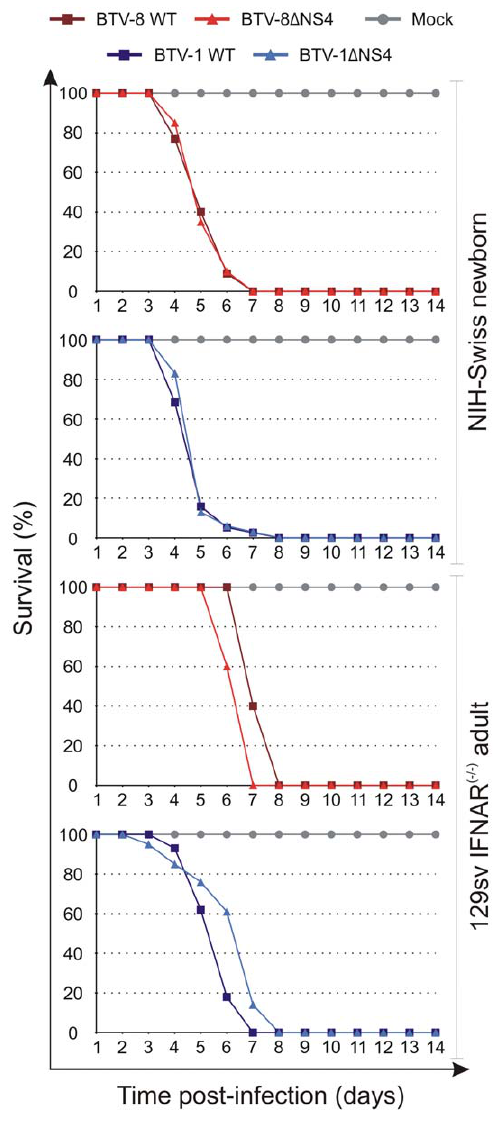
Figure 9. Experimental infection of Swiss new born and IFNAR ( 2 / 2 ) adult mice with wt and D NS4 viruses. Survival plots of either 3-days old mice inoculated intracerebrally or adult sv129 IFNAR ( 2 / 2 ) inoculated intraperitoneally with the following viruses: BTV- 8 (dark red, square), BTV8- D NS4 (red, triangle), BTV-1 (blue, square) and BTV1- D NS4 (light blue, triangle) viruses. Mock-infected mice are shown in gray, circle. Mice were killed at two weeks post-inoculation, or earlier, if showing advanced clinical signs of systemic